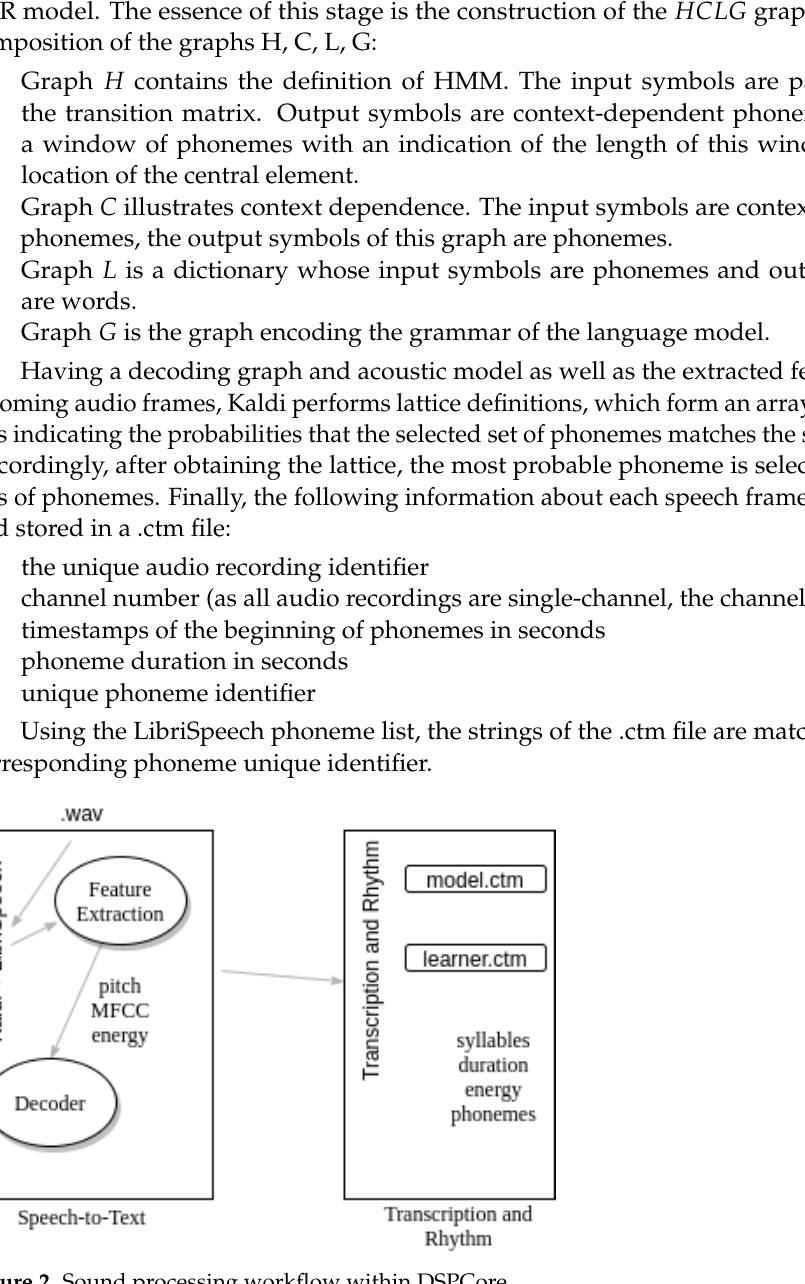
Figure 2. Sound processing workflow within